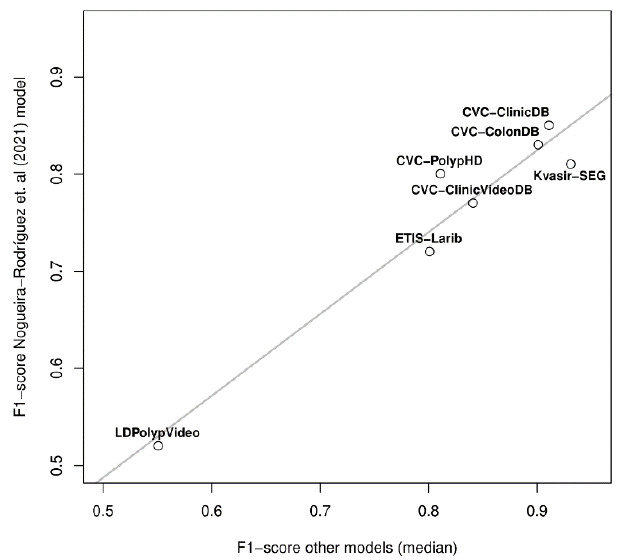
Figure 9. Correlation between the median inter-dataset F1-score of published studies and ours in seven public colonoscopy image datasets.